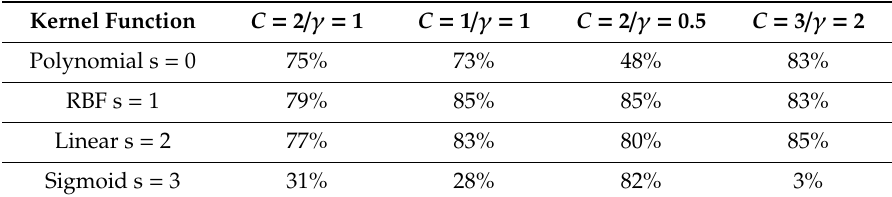
Table 1. Test results of di ff erent kernel functions.